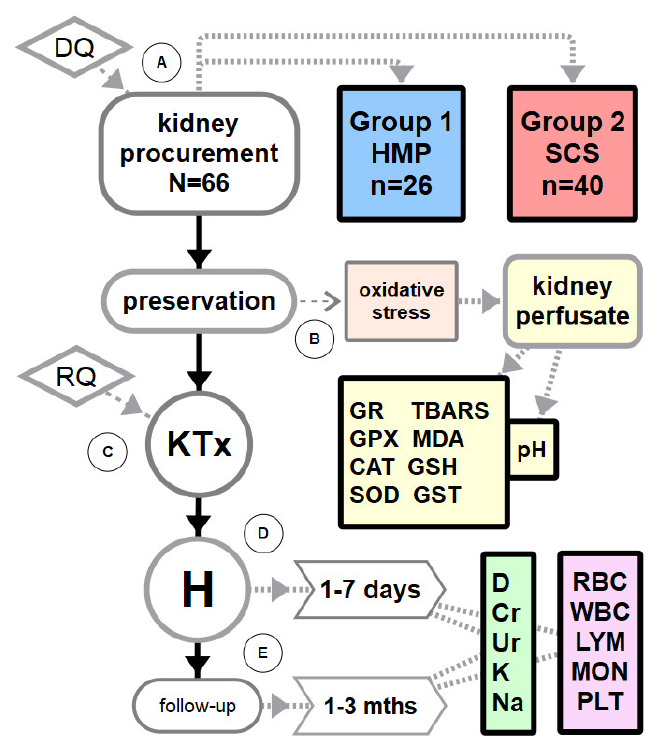
Figure 1. Study flowchart. Legend: DQ—donor qualification, HMP—hypothermic machine perfu-